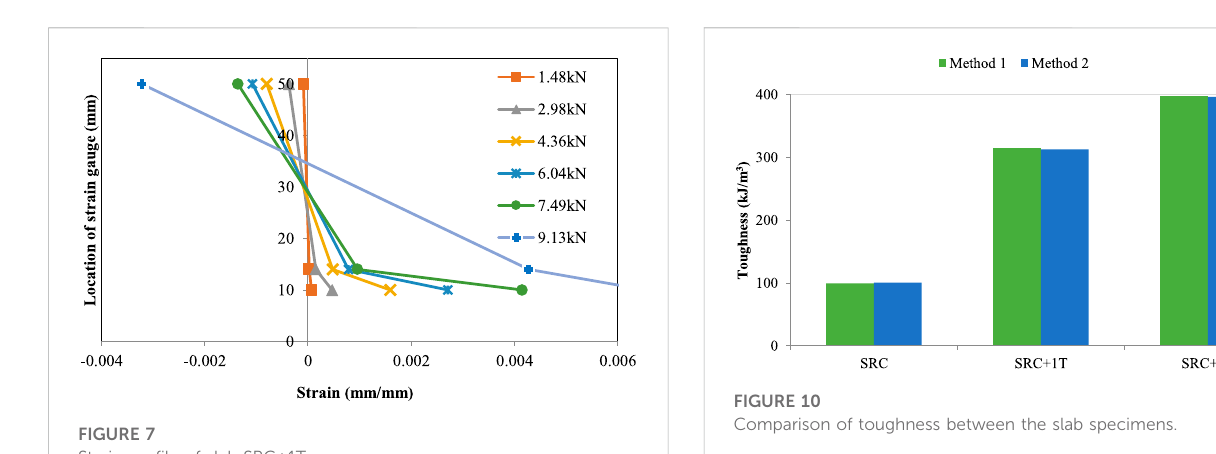
FIGURE 9 Variationofthedepthofcompressionzone(x/d)withrespecttothe applied load.